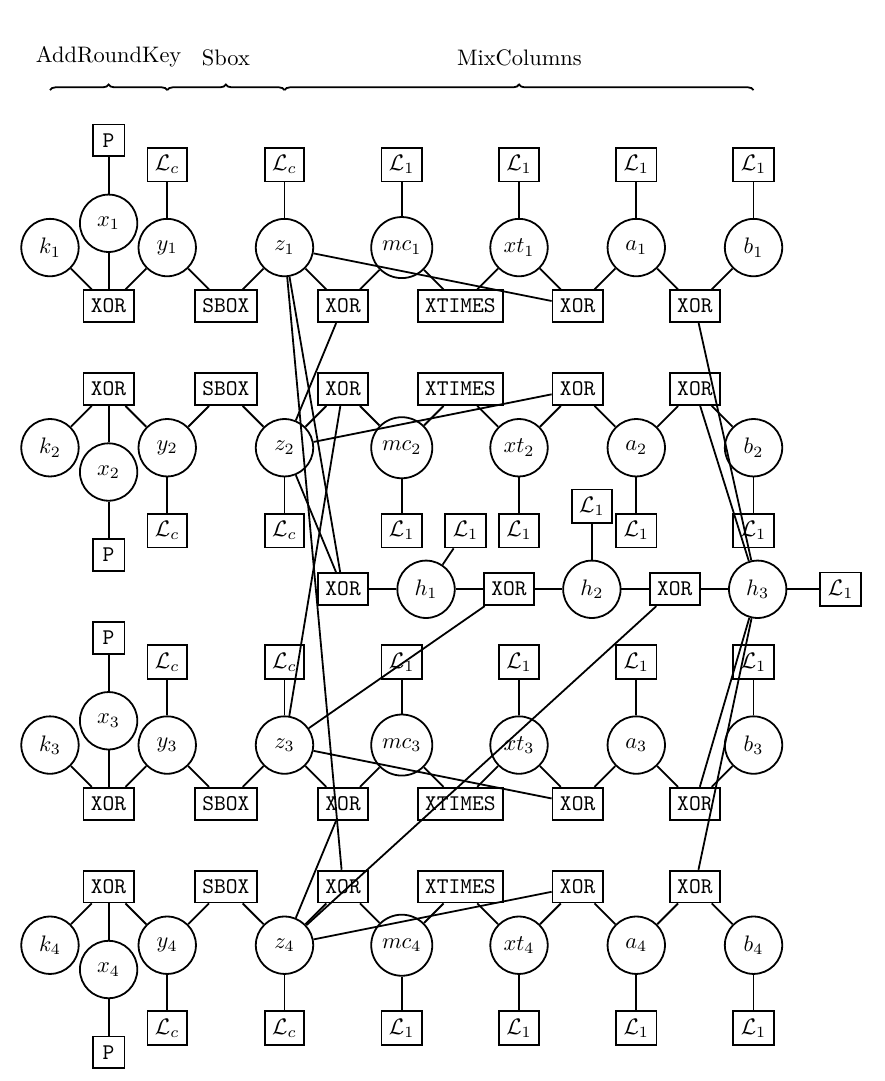
Figure 5: Factor graph for the first round / first column of the AES (adapted from